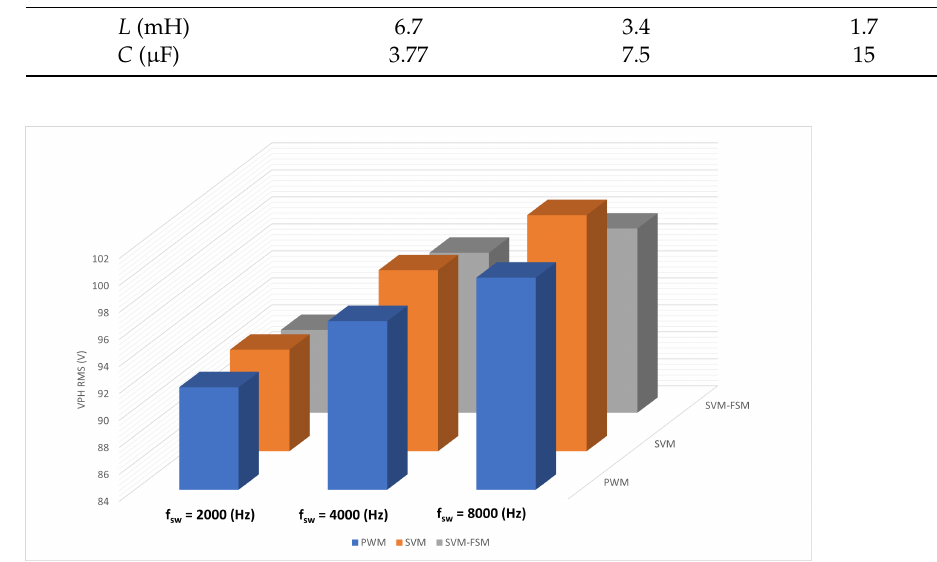
Figure 14. Effective voltage (RMS) depending on the switching frequencies and modulation type.